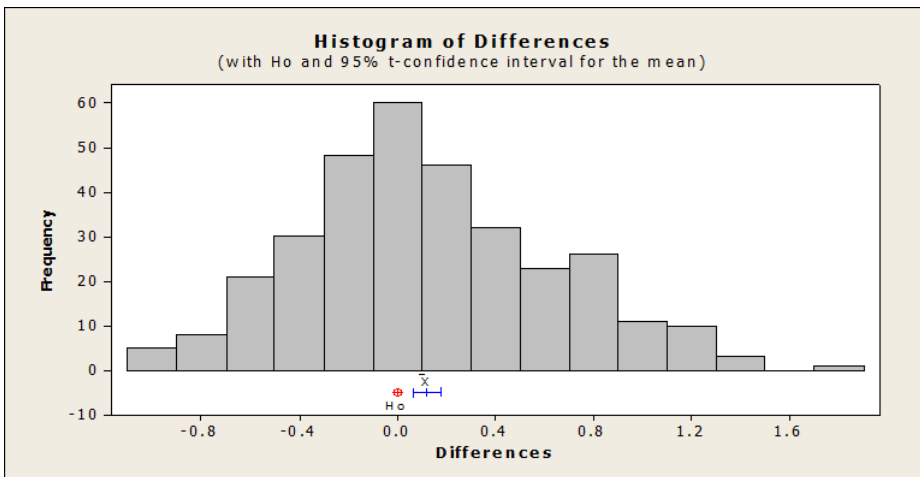
Figure 14. Histogram of differences for MHS and TVNS-SA performance.